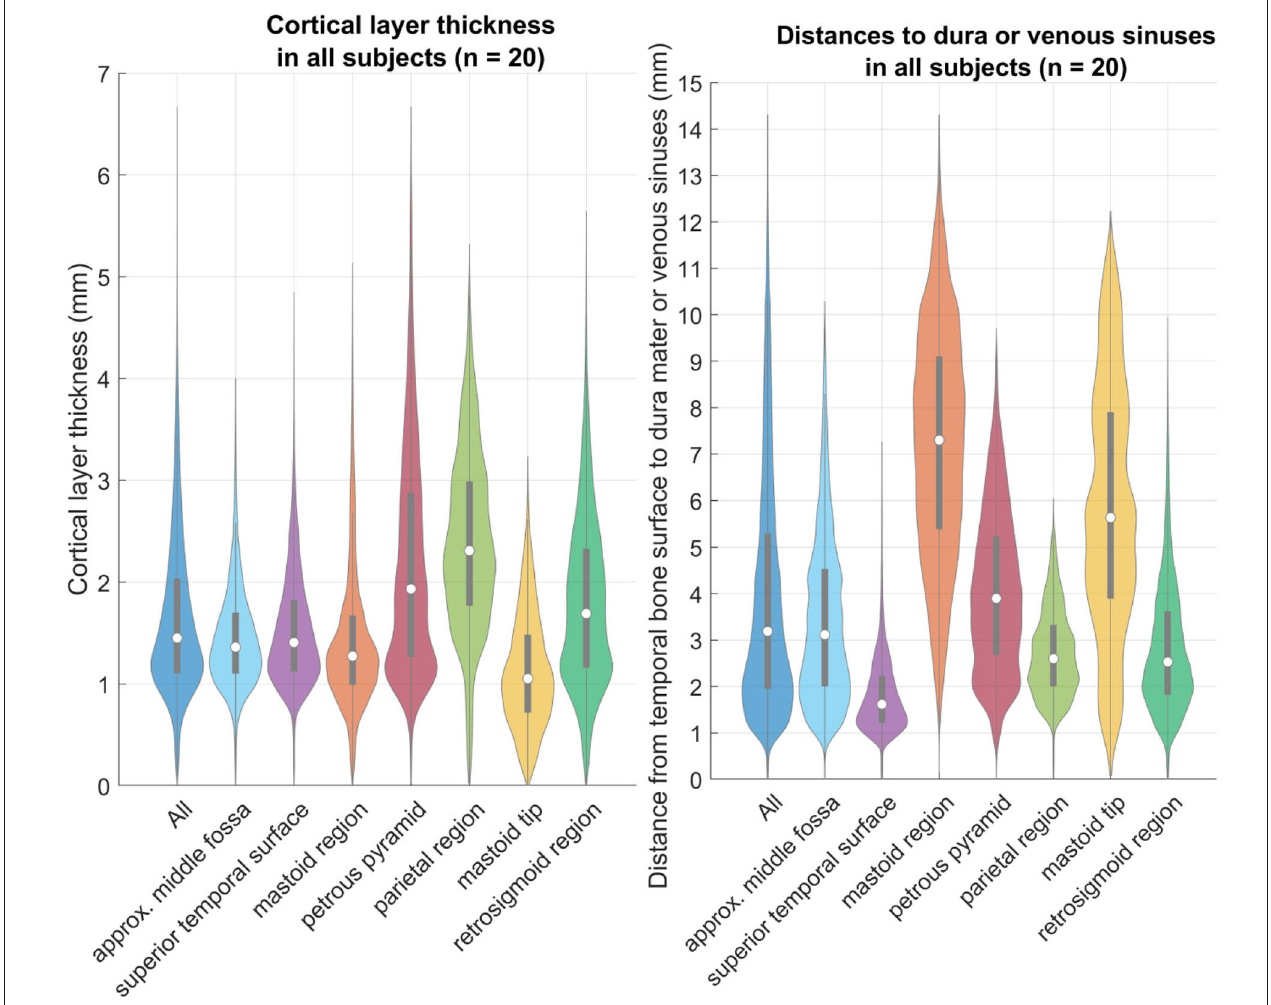
FIGURE 7 | Left: relative distributions of the cortical layer thickness (CLT) in the individual regions as defined above. Right: relative distributions of the distance to the dura or venous sinuses (DDVS). These violin plots are a variation of boxplots, that also show the distribution similar to a histogram (18). The gray bars within the violin plots are the lower and upper quartiles, and the white circle is the median value.